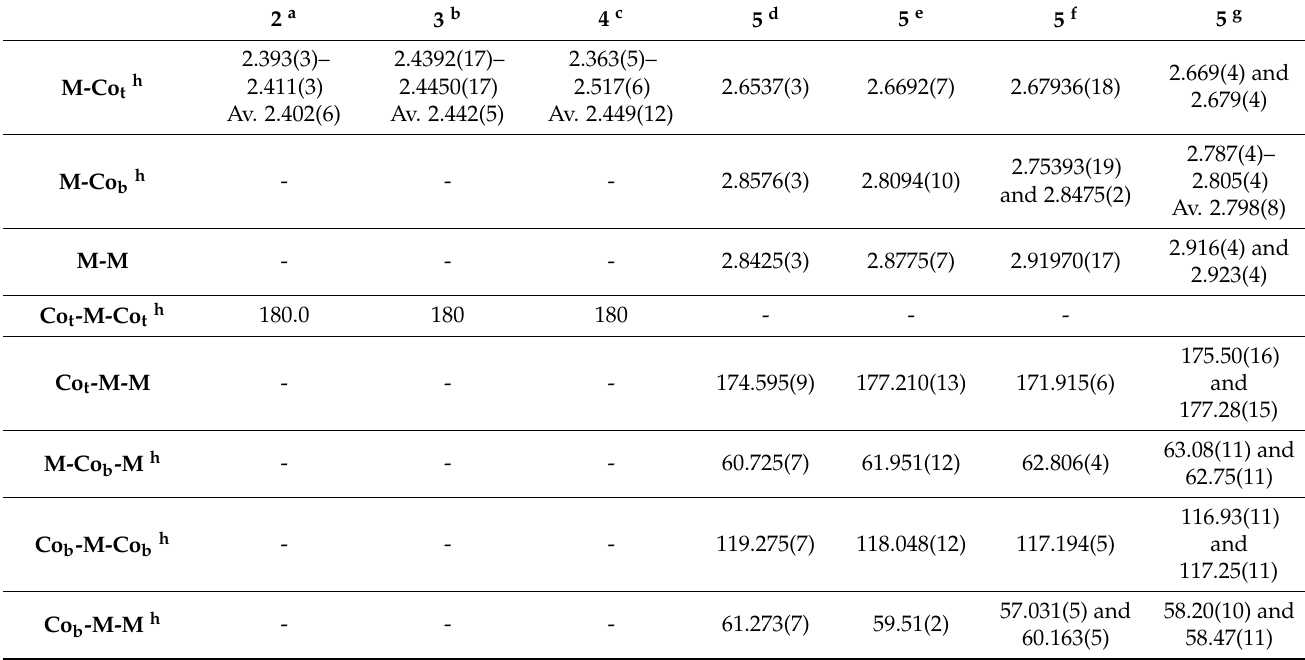
Figure 4. Molecular structures of 2 as found in ( a ) [Cu(dmpe) 2 ]( 2 ) (eclipsed conformation; TBP-TBP eclipsed isomer) and ( b ) [PPN]( 2 ) (TBP-Td isomer). Sub Van der Waals M ··· C(O) contacts are represented as fragmented lines (brown, Cu; blue, Co; red, O; grey, C) [40].